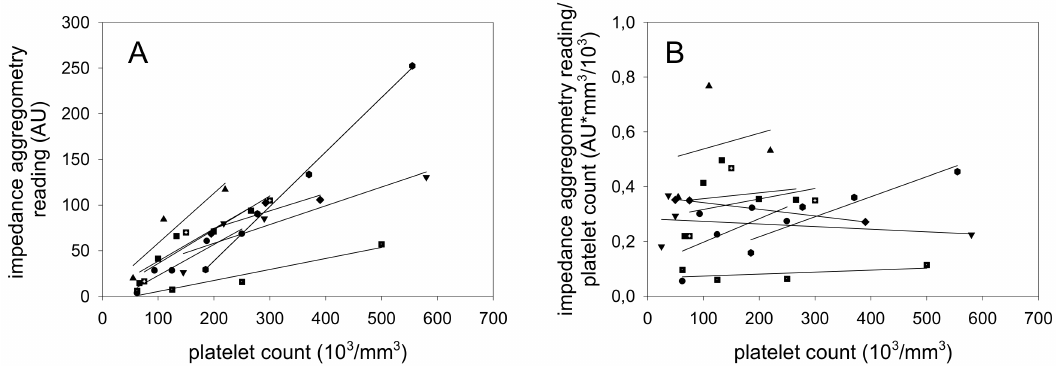
Figure 2. Platelet function as determined with impedance aggregometry in 8 healthy probands. Shown are individual dilution experiments demonstrating the e ff ect of the platelet count on impedance aggregometry readings ( A ) before and ( B ) after correction for the platelet count. Individual correlation in ( A ) ranged from 0.88 to 0.94 ( p < 0.05). Note, that more than 5-fold di ff erences in aggregation between probands can be observed after correction for the platelet count ( B